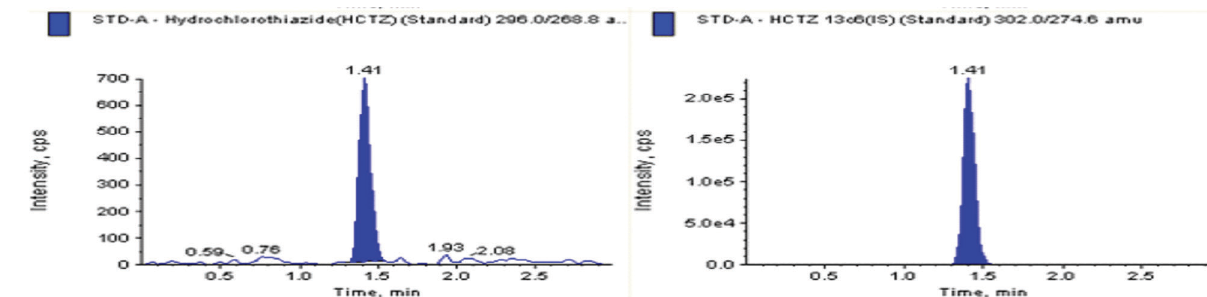
FIGURE 8 - Representative chromatogram of standard HCT (LLOQ sample). TABLE III - Recovery and matrix effect of CAN and HCT QC